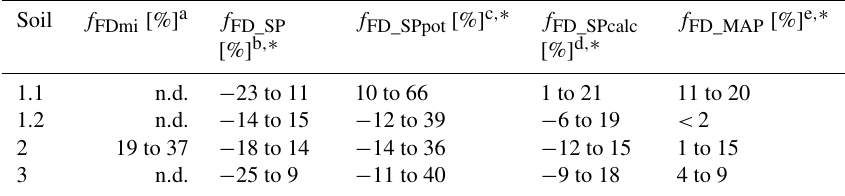
Table 5. Ranges of the fraction of N 2 O produced by fungi ( f FD ) from four soils using different approaches: fungal fraction was calculated using the microbial inhibitor approach (modified SIRIN) ( f FDmi ) (footnote a), the isotopomer end-member mixing approach (IEM) by SP isotope mixing balance using variant + C 2 H 2 ( f FD_SP ) (footnote b) and f FD_SPpot (footnote c) for results from variant − C 2 H 2 assuming the SP effect of N 2 O reduction was negligible and for results from variant − C 2 H 2 with reduction correction to calculate the SP N ( f FD_SPcalc ) (footnote d), and the δ 18 O/SP Map ( f FD_MAP ) (footnote e) with δ 18 O N + C 2 H 2